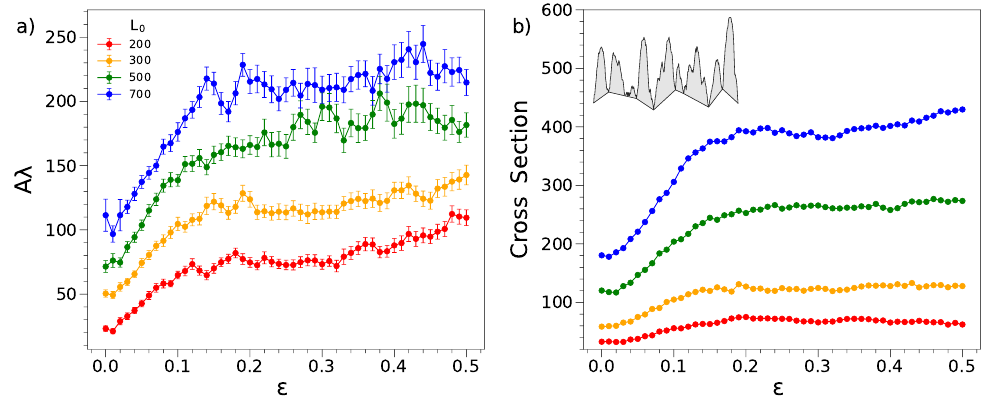
Figure 6. ( a ) Product of the average amplitude A and wavelength λ of the wrinkling. The product is a proxy of the cross section of a wrinkle. The relative increases in the amplitude in the range 0.25 ≤ ε ≤ 0.5 with respect to the overall increase are 0.43,0.32,0.15,0.05, from the shortest to the longest film. The curves corresponding to L 0 = 300,500,700 have been shifted upwards by 20,40,60 units, respectively, for clarity. ( b ) Overall cross section of the wrinkling (error bars smaller than the dot size). The sketch illustrates the evaluation according to the PH algorithm detailed in Section 3. The relative increases in the amplitude in the range 0.25 ≤ ε ≤ 0.5 with respect to the overall increase are − 0.33,0.05,0.09,0.14 from the shortest to the longest film. Both the quantity A λ and the cross section are in units of σ 2 ; see Section